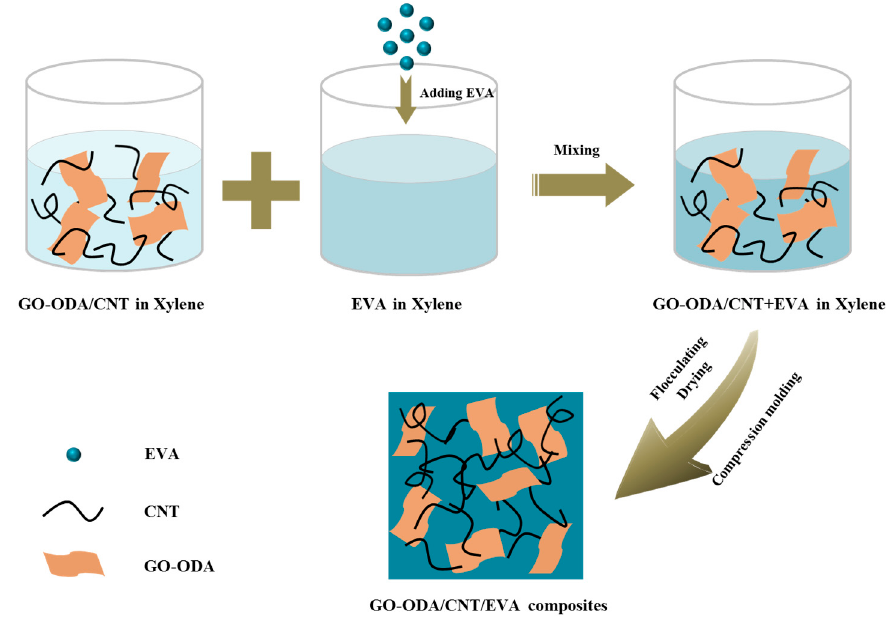
Figure 1. Scheme of the fabrication process of the G–CNT/EVA composites.